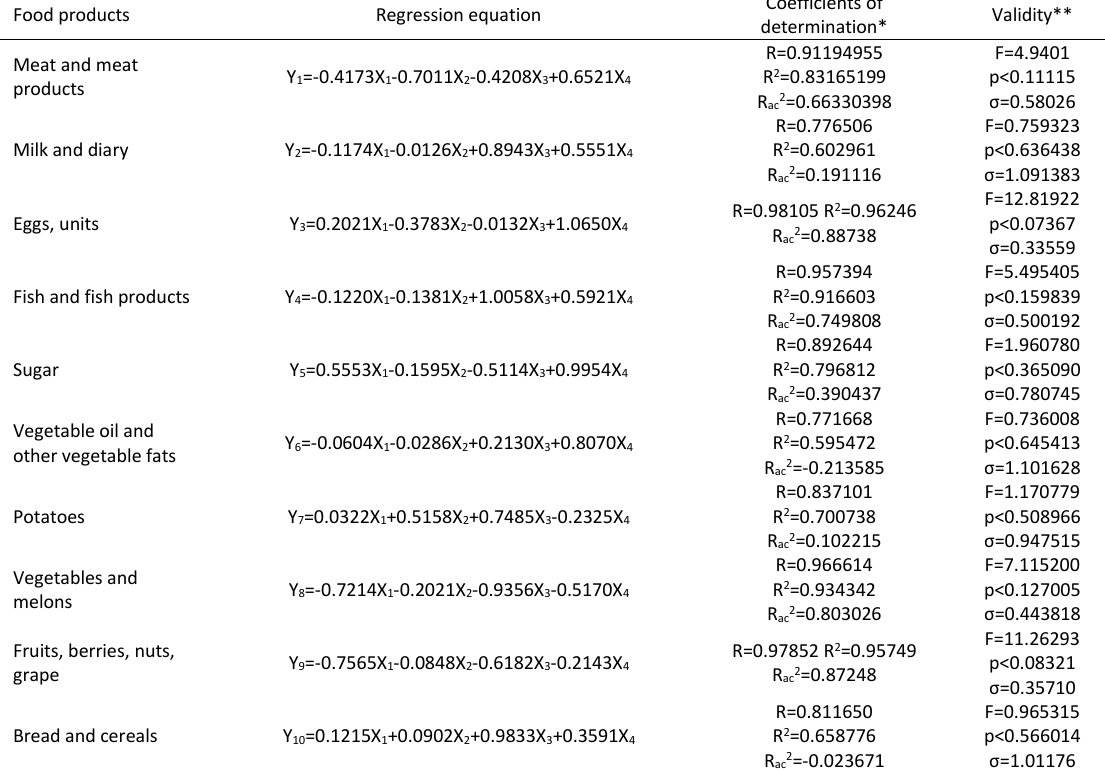
Table 2: The dependence of the level of main food products consumption on certain factors in Ukraine in 2010-2017 (regression analysis) Food products